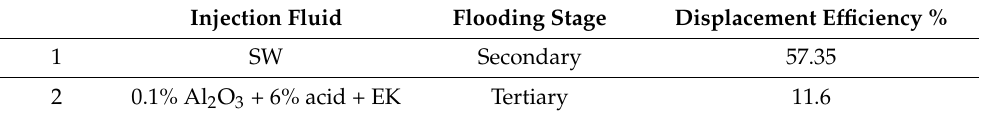
Table 13. Summary of CF6.